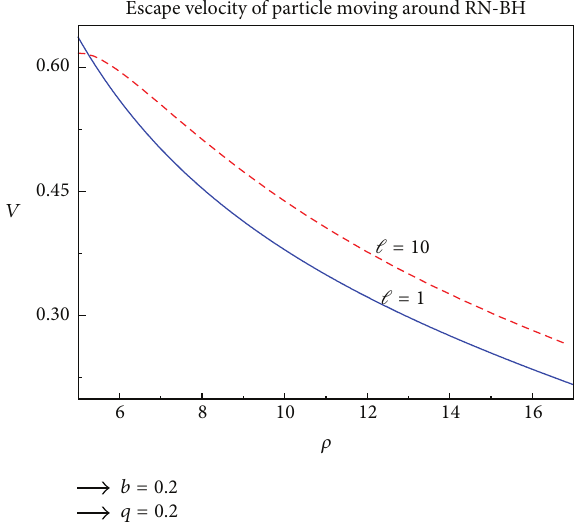
Figure 16: Escape velocity ( V esc ) against 𝜌 for different values of angular momentum ℓ